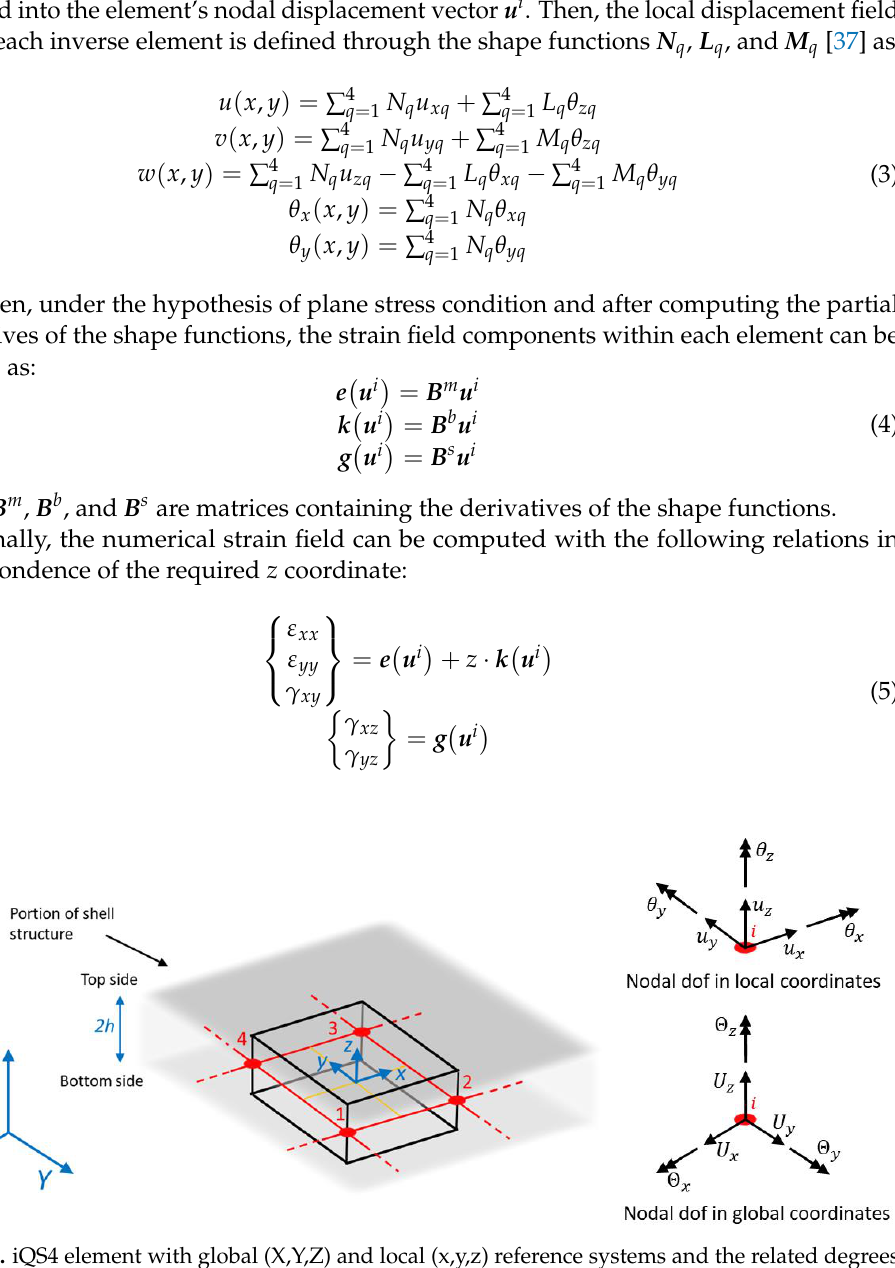
Figure 2. iQS4 element with global (X,Y,Z) and local (x,y,z) reference systems and the related degrees of freedoms (dof). Numbers 1 to 4 refer to the element nodes.